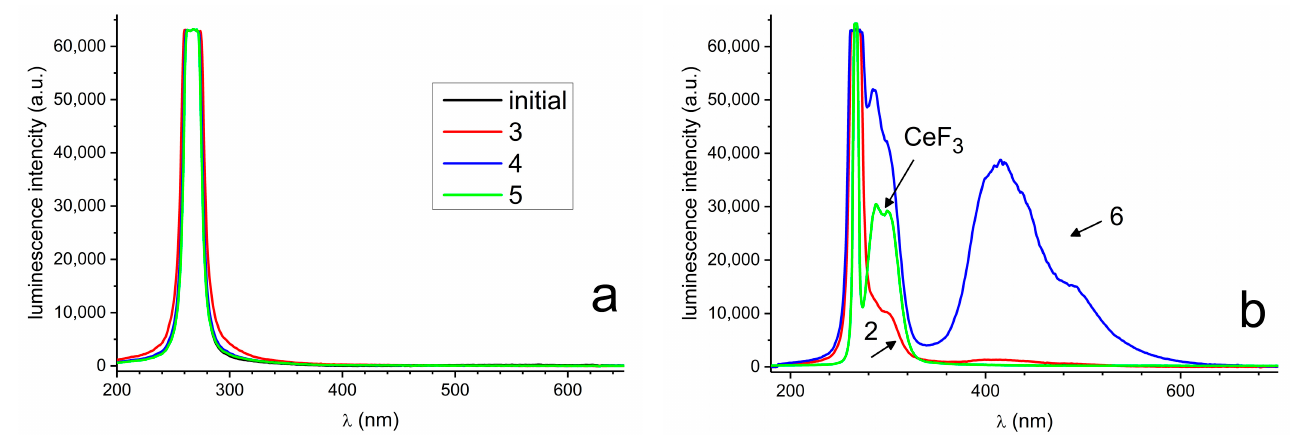
Figure 4. The luminescence spectra of the studied samples; ( a ) spectra of initial sample and samples of 3, 4, and 5; and ( b ) spectra of samples 2 and 6 in comparison with the spectrum of CeF 3